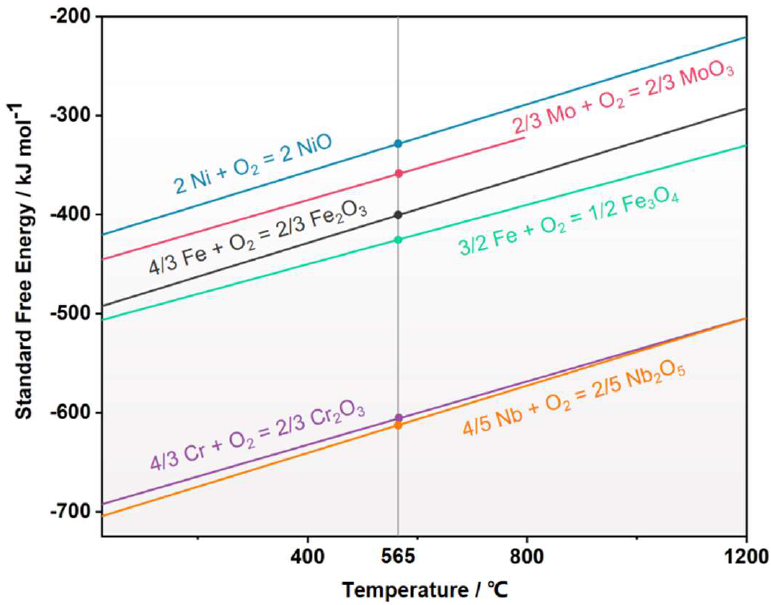
Figure 10. The standard formation free energy of main metal oxides formed in this study as a function of temperature.